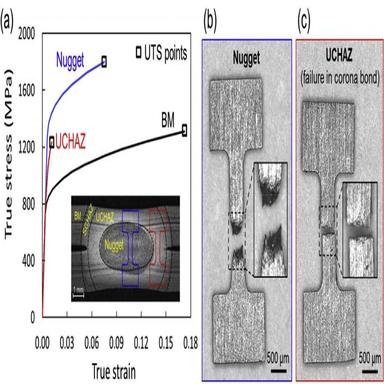
Miniature tensile test results of the 6.5 kA joint. (a) True stress-true strain curves; (b) and (c) fractured samples of nugget and UCHAZ, respectively.